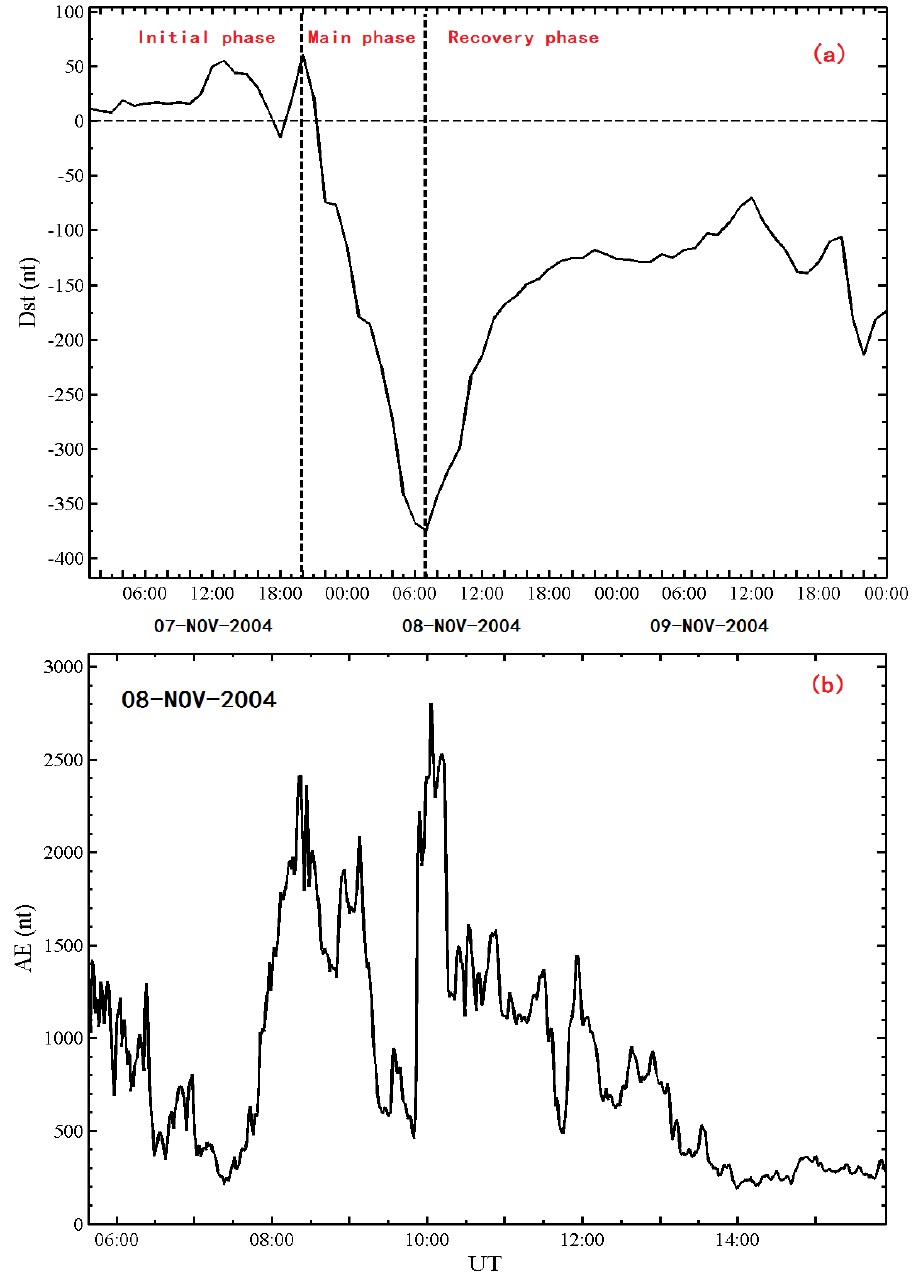
Figure 2. Geomagnetic indices. ( a ) The Dst index from 7 November 2004 to 9 November 2004 is shown in the top picture. ( b ) The AE index from 06:00 UT to 16:00 UT on 8 November 2004 is shown in the bottom of the picture.